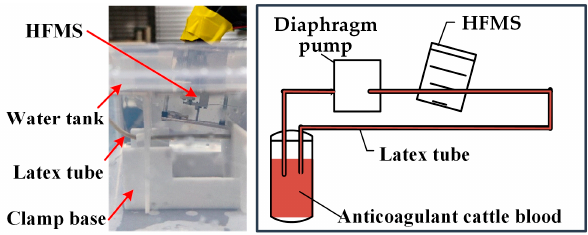
Figure 10. The fl ow phantom photos and schematic diagram.